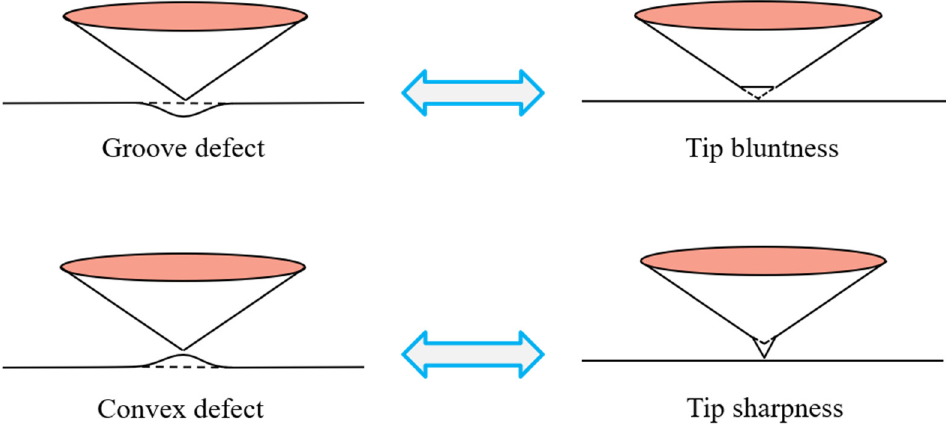
Figure 11. Schematic of the comparison between surface defects and tip irregularity.